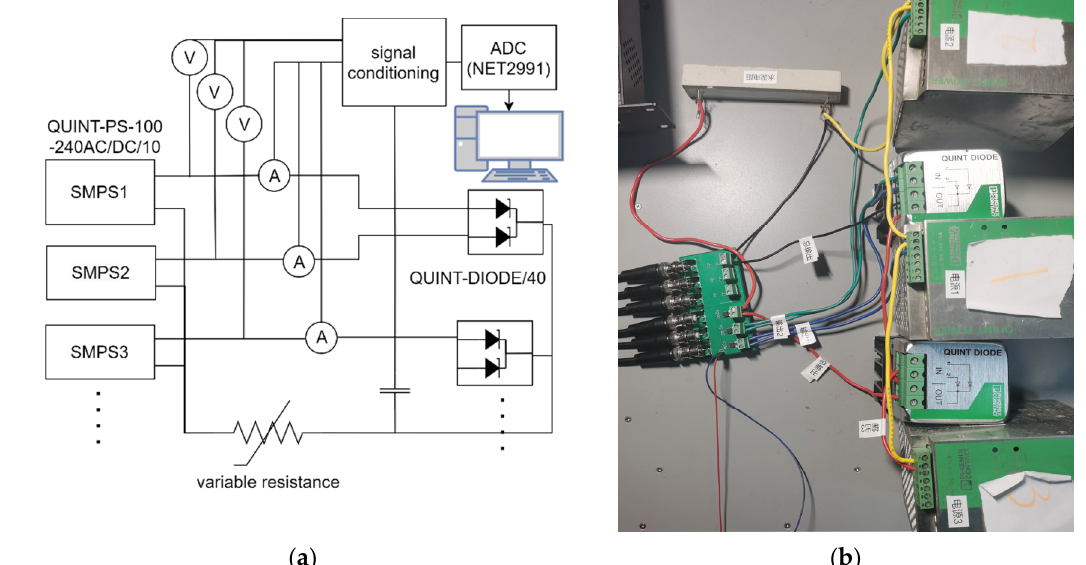
Figure 7. ( a ) the structure of the experiment platform; ( b ) the experiment platform.